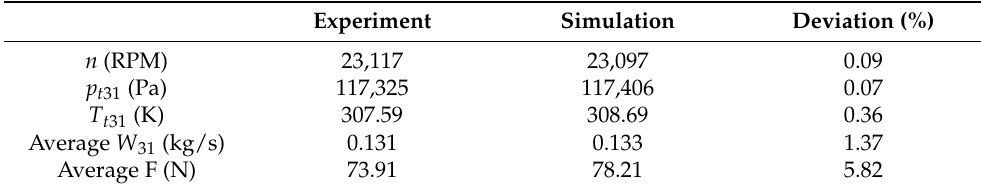
Table 2. Experiment and simulation results of PDTE at f = 10 Hz.